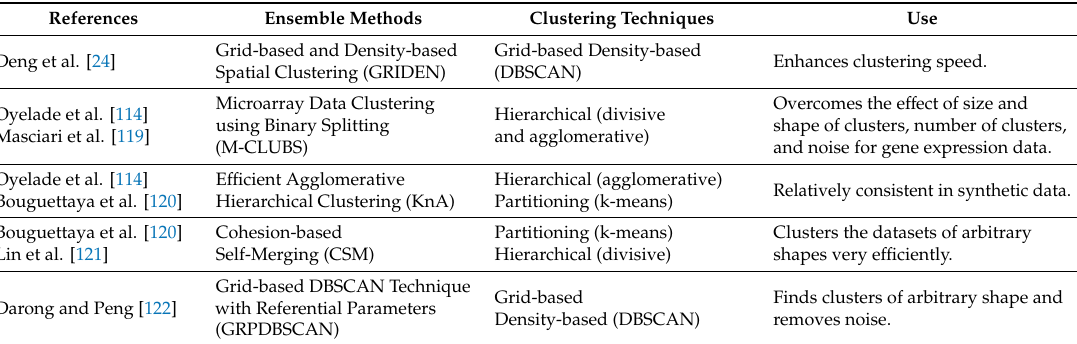
Table 8. Summary of the existing ensemble methods used in